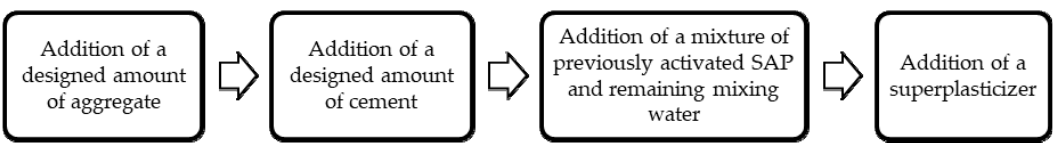
Figure 3. Method O: The order in which components were added to the concrete mix when using the methodology of adding activated superabsorbent polymers (SAP).